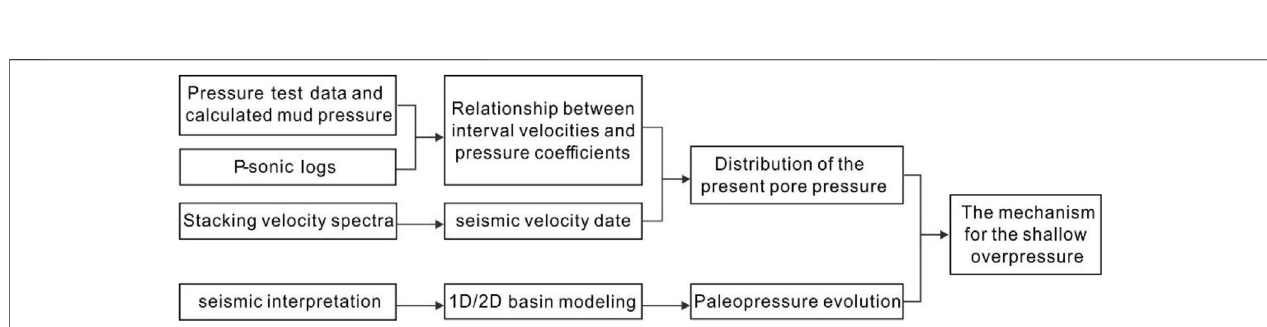
FIGURE 3 | The fl ow chart of studying the distribution and formation mechanism of the shallow overpressure in the QDNB.